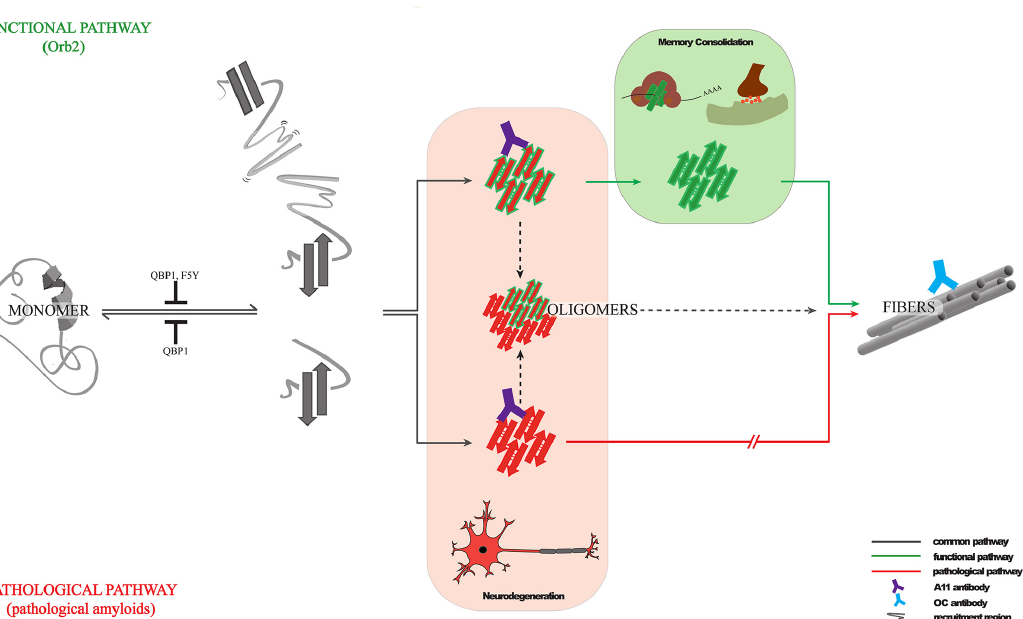
Fig 8. Structural basis of memory consolidation mediated by Orb2 amyloid. In Drosophila , the Orb2 protein ( top ) is a functional amyloid with self- sustaining prion-like properties that follows an amyloidogenic pathway resembling that of pathological amyloids ( bottom ). During the assembly pathway, Orb2 and pathological amyloids can form A11-reactive toxic oligomers, and Orb2 can be sequestered by pathological amyloids to form hetero-oligomers. However, intrinsic structural features make Orb2 toxic oligomers rare and transient, suggesting that this functional amyloid appears to have been honed by evolution in adopting a self-sustaining amyloid-like state much more efficiently than pathological amyloids in order to avoid cytotoxicity and perform its role in memory consolidation. This function is supported by the amyloid state of Orb2, since its inhibition by an anti-amyloidogenic peptide (QBP1) selectively interferes with the long-term persistence of